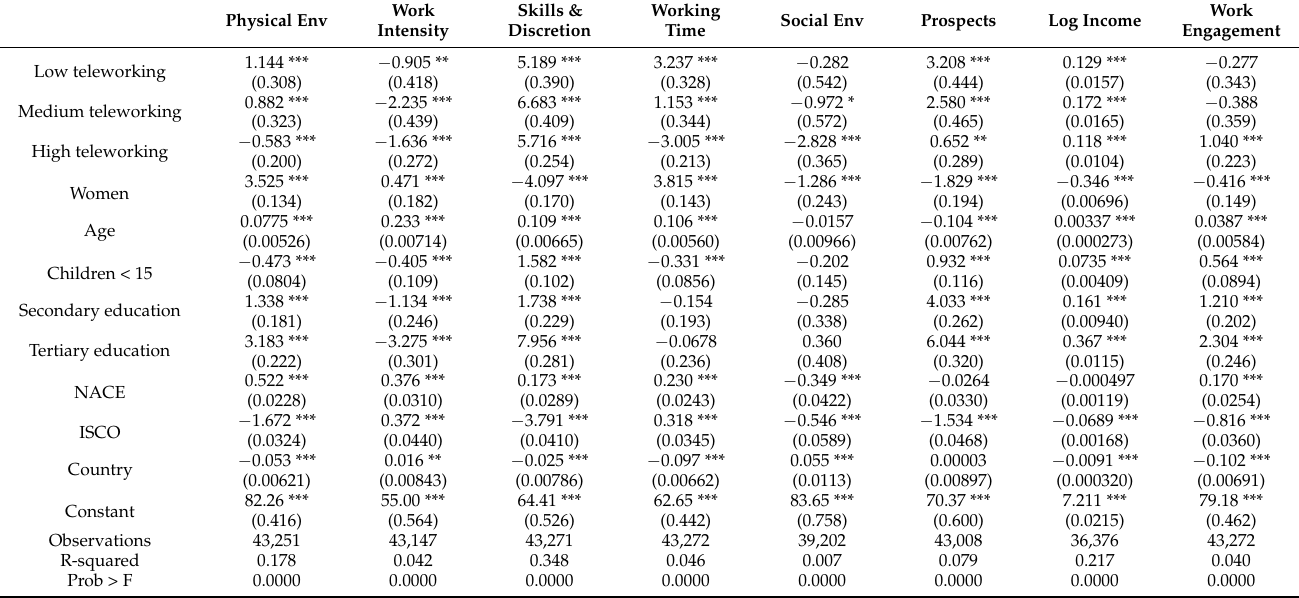
Table 2. Standardized coefficients of OLS regressions in 35 European countries. Source: Own elaboration based on